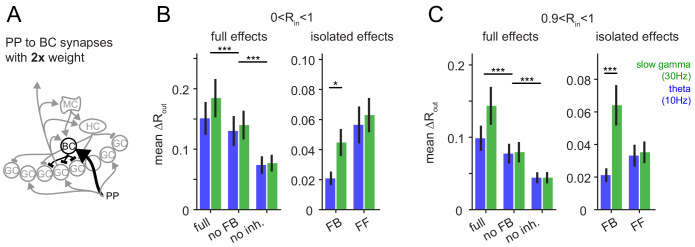
Robustness for increased feedforward inhibition.To test if the frequency-dependent enhancement of feedback inhibitory pattern separation of highly similar inputs was sensitive to the changes in the relative strengths of feedforward and feedback inhibition, we increased the perforant path (PP) to basket cell (BC) synapse weight 2x. (A) Illustration of the network alteration. (B) The resulting full pattern separation effects (left) and isolated feedback (FB) and feedforward (FF) effects (right) as mean over all input similarities. (C) Same as (B) but only for highly similar input patters. Full effects were tested with 2 × 3 ANOVAs followed by Sidak’s postests for differences between conditions. Isolated effects were tested with 2 × 2 ANOVAs followed by Tukey posttests for differences between frequencies. Asterisks indicate significance in posttests given significant overall effects (*p<0.05,**p<0.01,***p<0.001).